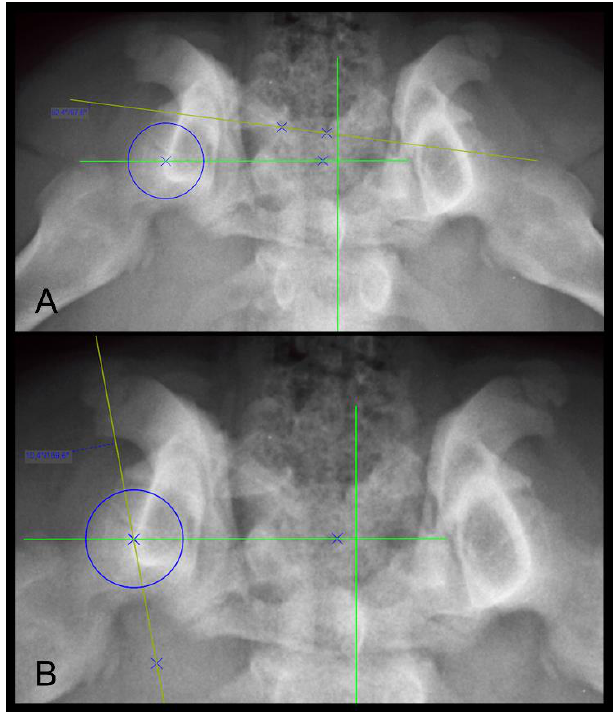
Figure 3. Dorsal acetabular rim view radiographs of the same Rottweiler shown in Figure 1 A,B as well as Figure 2. Measurement of the dorsal acetabular rim slope is demonstrated on ( A ) and of the center edge angle on ( B ). Right is always to the left of the image. center edge angle on ( B ). Right is always to the left of the